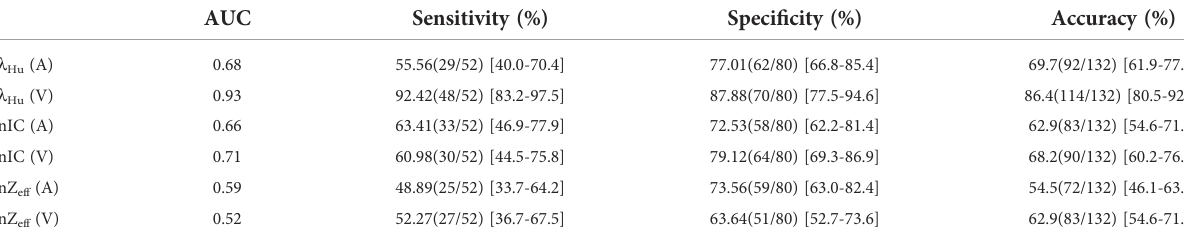
TABLE 2 The receiver operating characteristic curves of the metastatic and non-metastatic lymph nodes were analyzed using the quantitative parameters of quantitative dual-layer spectral CT.